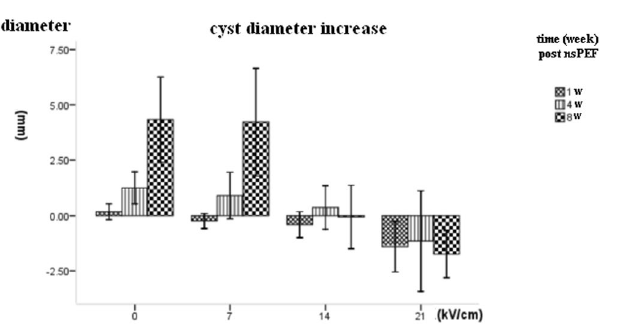
Figure 4. The diameter increase of mouse hepatic cystic echinococcosis lesion over time after different nsPEF dosages. To better reflect the growth tendency, the cyst diameter increase on the 1st, 4th and 8th week after nsPEF treatment were measured and